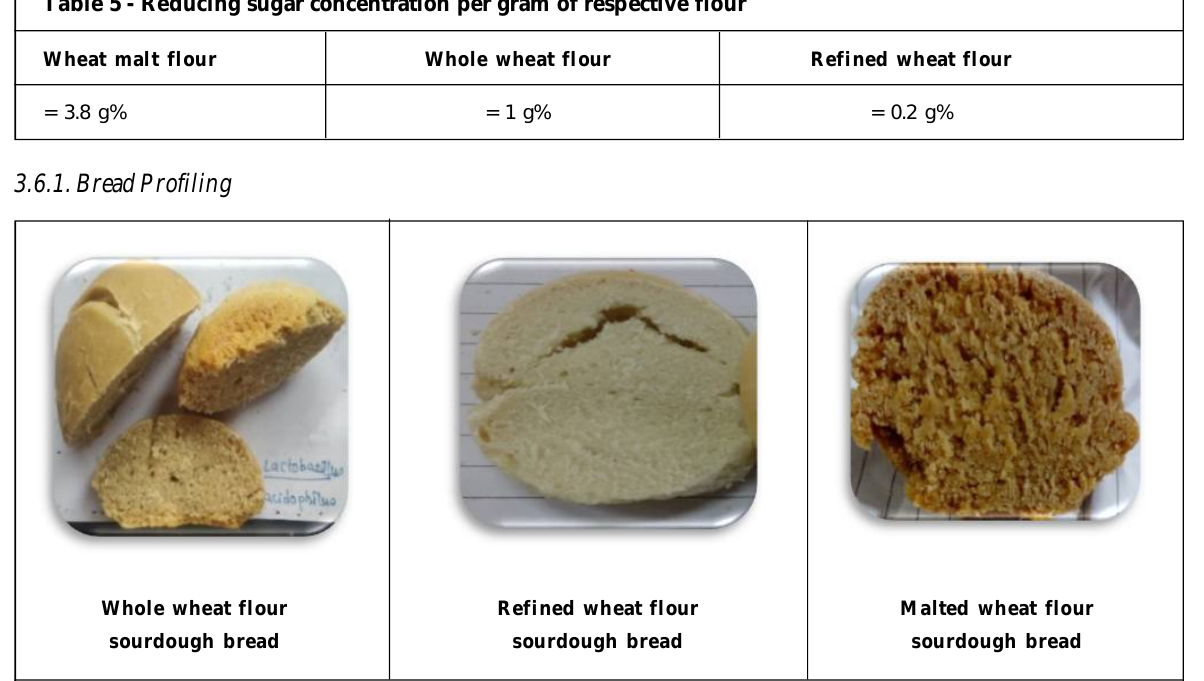
Whole wheat flour sourdough